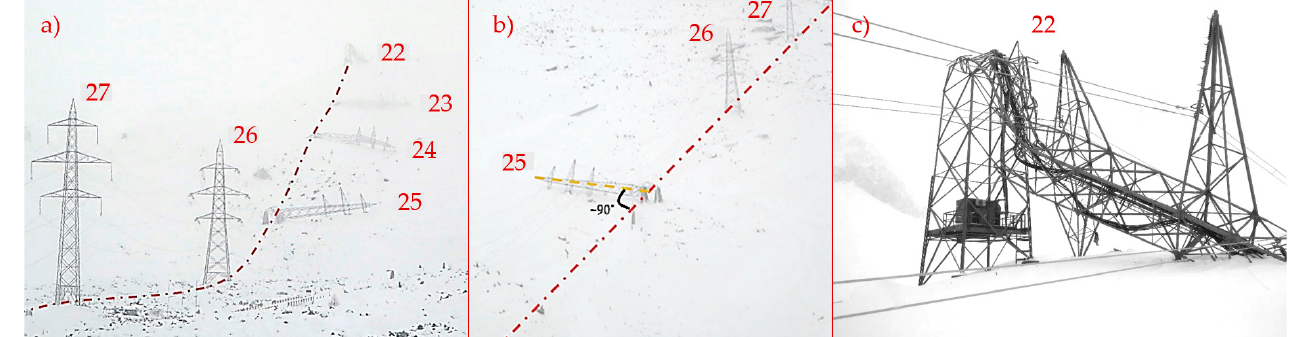
Figure 1. Pictures after the storm in 2018: ( a ) towers from No. 22 to No. 26. Marked in red, the line path: towers No. 22 to No. 25 fallen perpendicularly to the line direction, No. 26 (tensioning tower) and No. 27 still intact; ( b ) arial view of tower No. 25: highlighted, the angle with respect to the tower axis; ( c ) close-up view of tower No. 22: note how the tower has failed at mid-height, and the base is still intact.